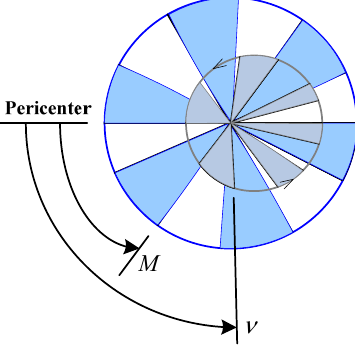
Figure 4. The geometric relationship between M and v .